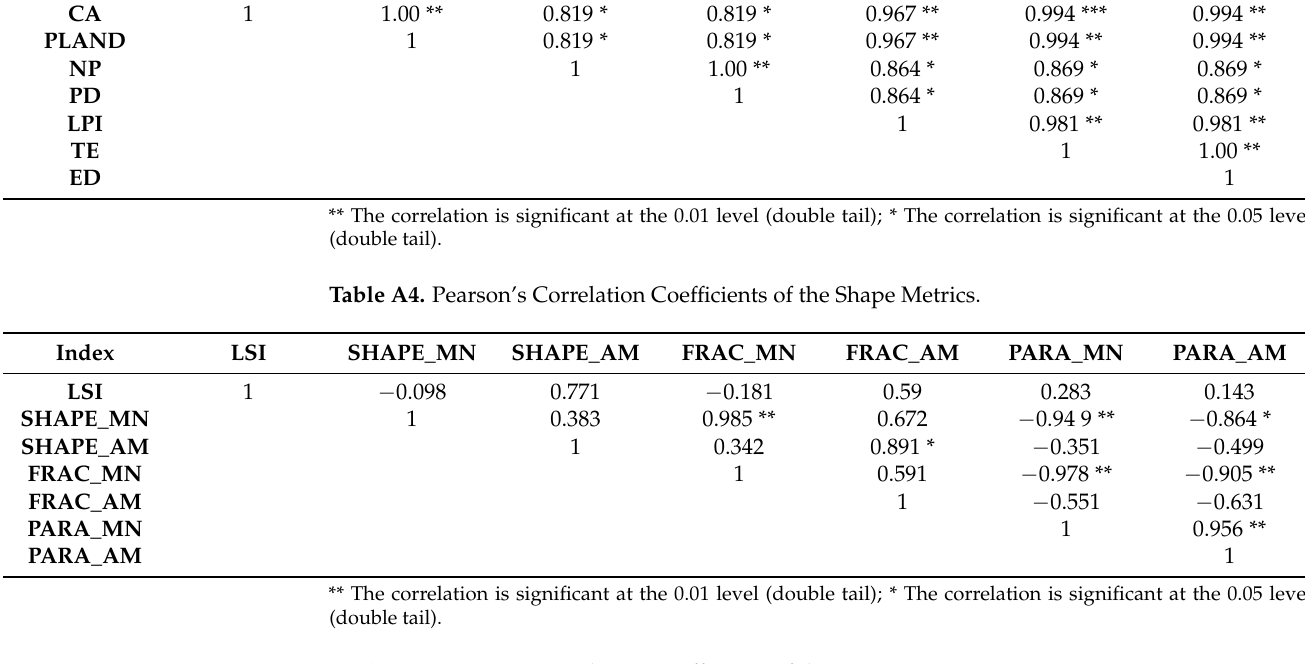
Table A5. Pearson’s Correlation Coefficients of the Aggregation